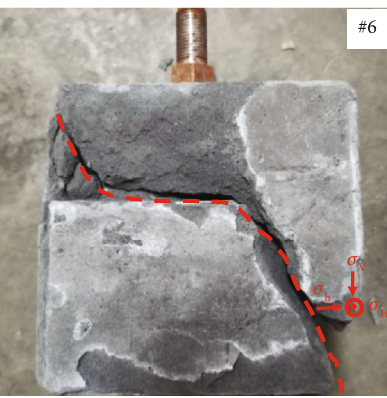
Figure 6: Fracture morphology under the injection rate of